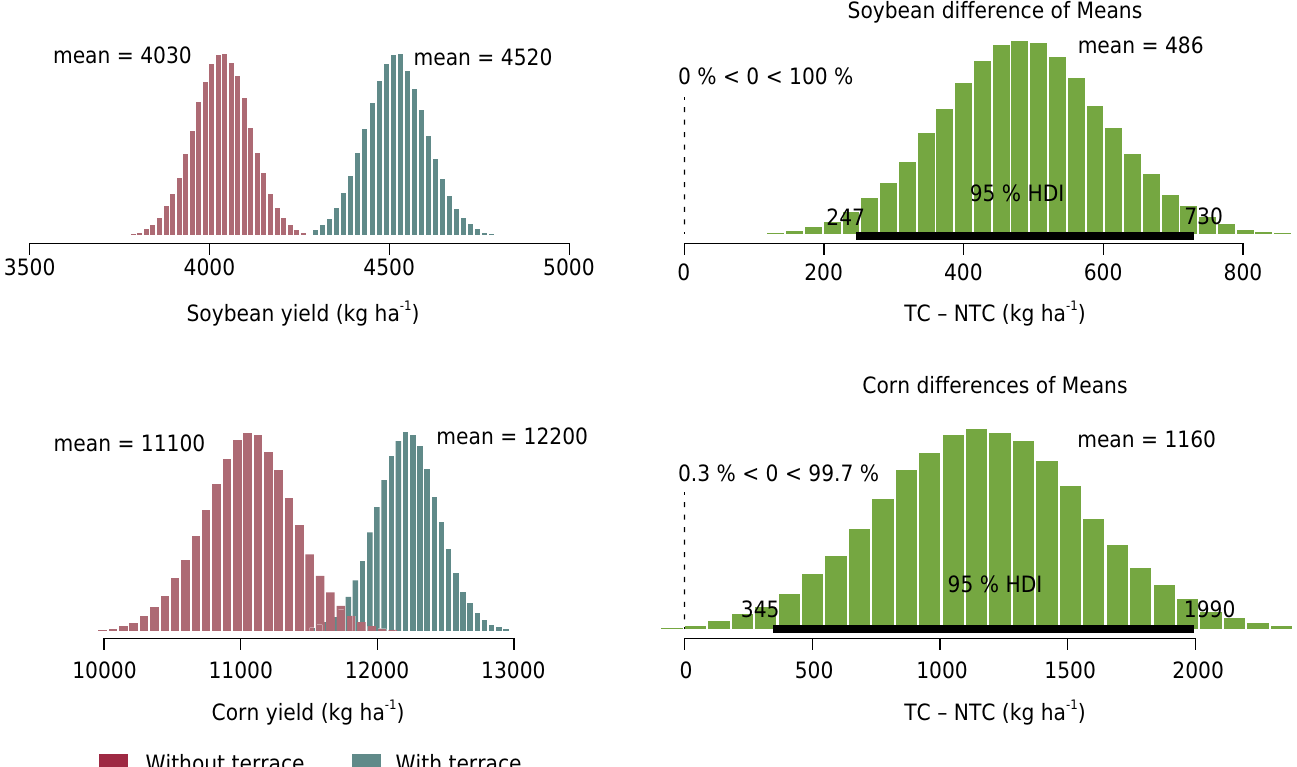
Figure 5. Histogram of grain yield for soybean and corn in the non-terraced catchment (NTC) and terraced catchment (TC) in Rio Grande do Sul State, southern